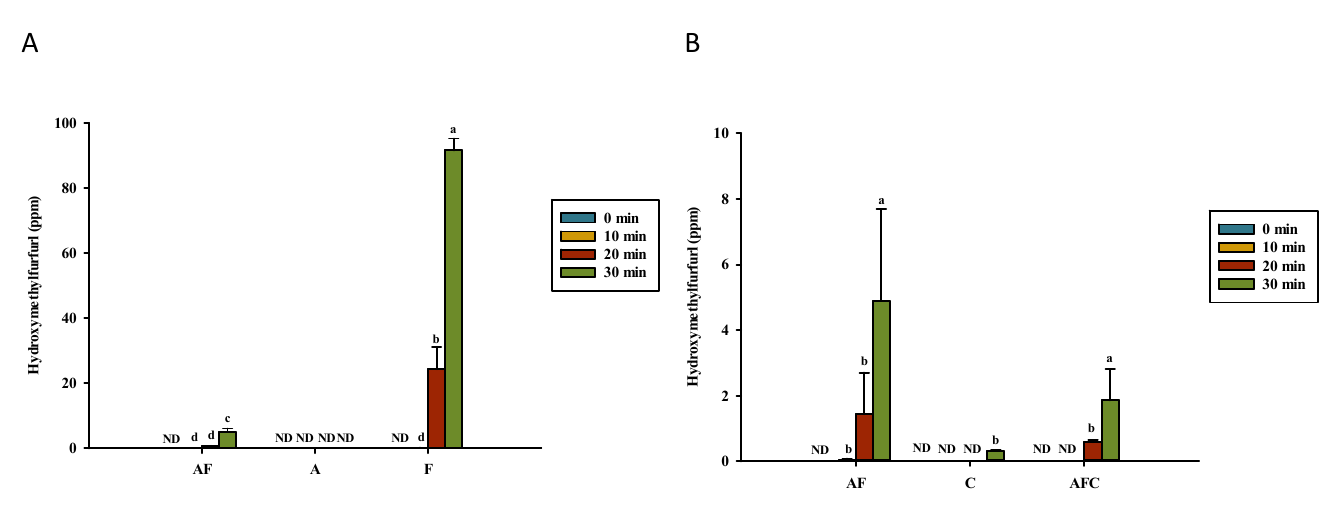
Figure 4. Hydroxymethylfurfural formation for various groups upon heating in ( A ) water and ( B ) acetic acid. AF, asparagine and fructose; A, asparagine; F, fructose; C, chitosan; AFC, asparagine, fructose and chitosan. Data represent the means of three replicates, and error bars indicate standard deviation. Bars followed by a common letter are not significantly different according to the Dunn’s test at the 5% level of significance (ND, not detected).